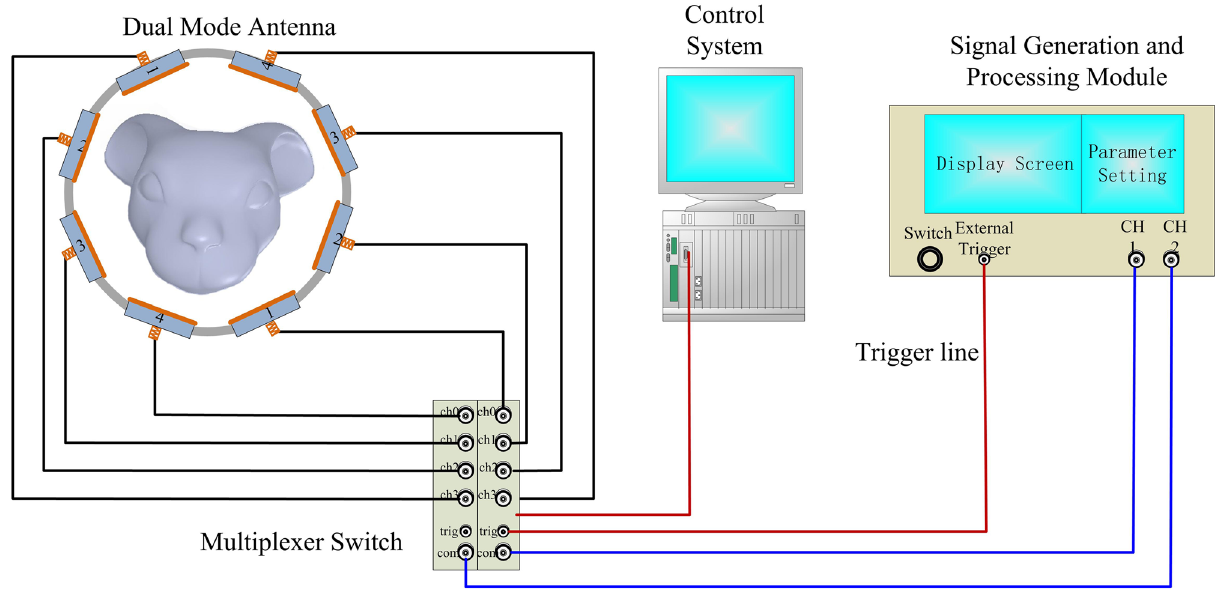
Figure 8. Construction of the multichannel microwave-based monitor Figure 7b shows a voltage source feeding into the antenna with a source impedance of Z 0 .